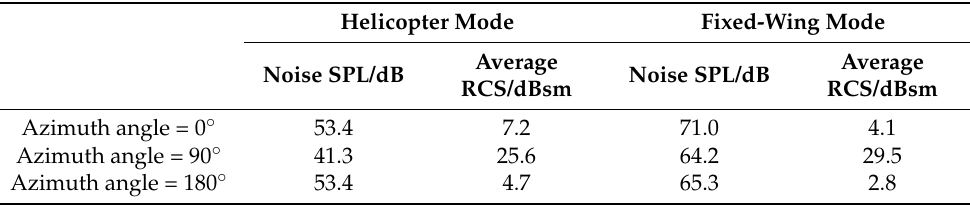
Table 19. Noise SPL and average RCS values with CSM phase parameters of Equations